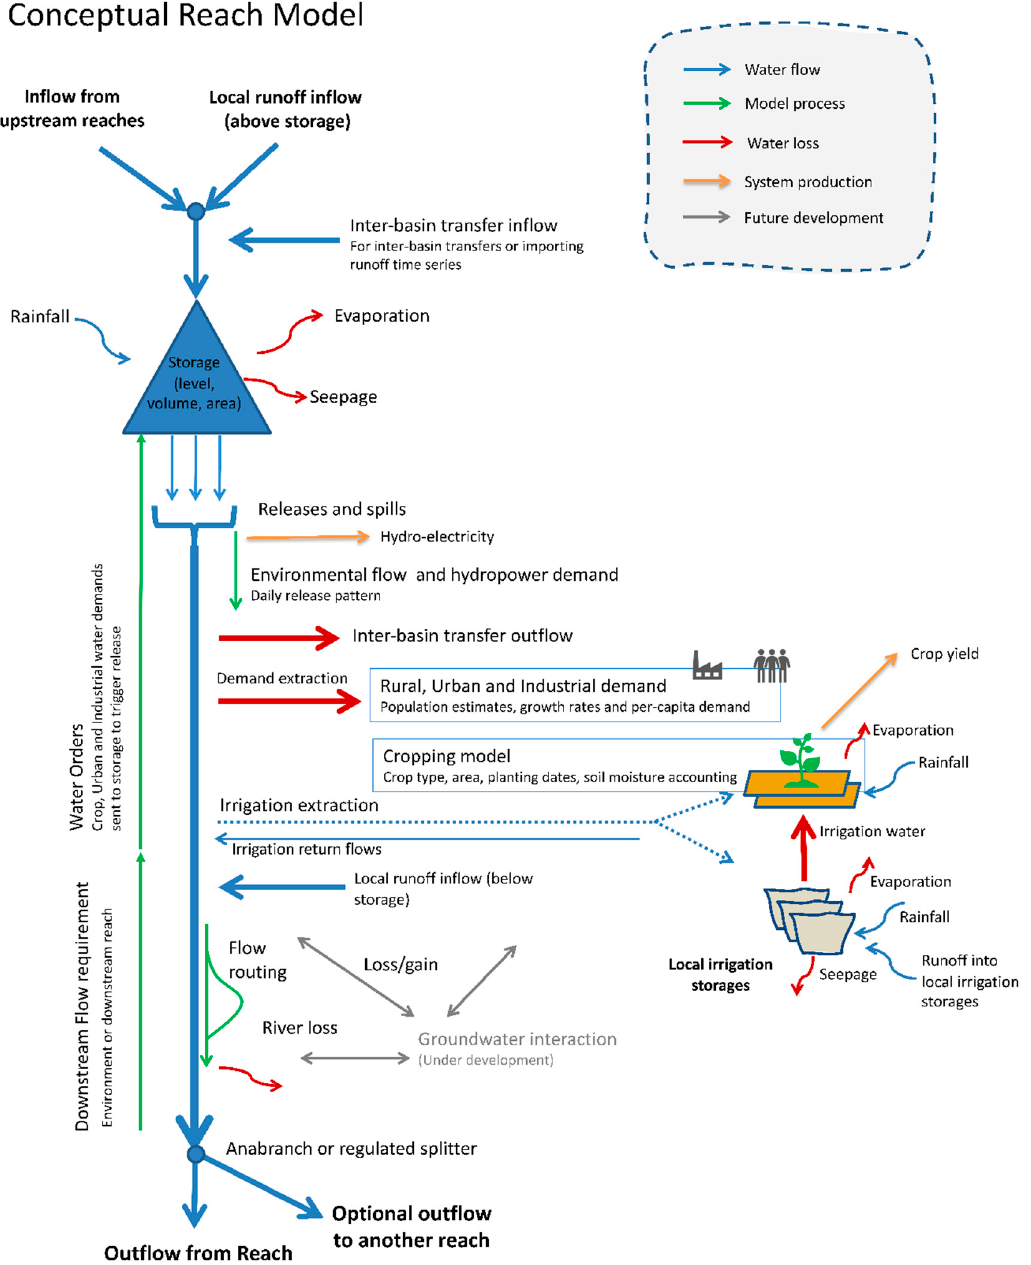
Figure 1. Conceptualisation of the reach model engine underlying Basin Futures.